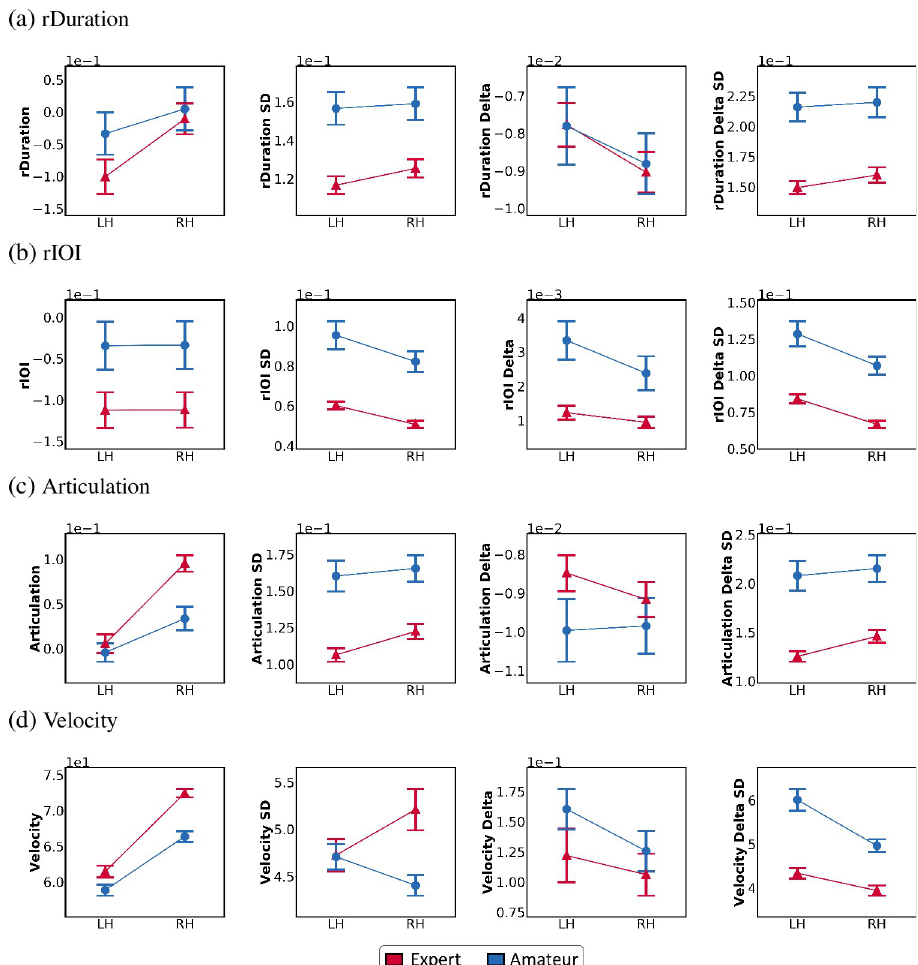
Fig 2. Comparison between hands for the Basic features in the expert and amateur groups. These line graphs show the main effects for both groups. The graphs are the results of an average of the feature values from both excerpts ("Hanon" and "Scale"). (a) The rDuration features as the mean, SD, Delta mean, and Delta SD. (b) The rIOI as the mean, SD, Delta mean, and Delta SD. (c) The Articulation features as the mean, SD, Delta mean, and Delta SD. (d) Velocity as the mean, SD, Delta mean, and Delta SD (expert, red; amateur,